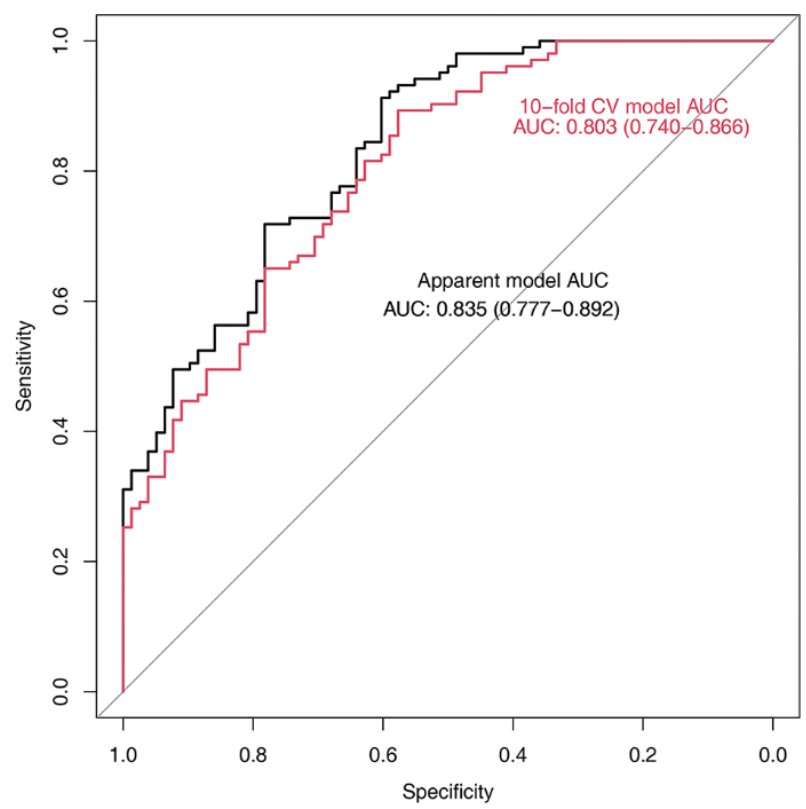
Figure 6. Adequacy of the prediction model for poor neurological outcomes in this study as determined using the Hosmer-Lemeshow test (Chi-squared = 11.4, df = 8, p = 0.178), along with the areas under the curve (AUC: 0.803, 95% confidence interval: 0.740–0.866). In this study, a 10-fold cross-validation (CV) analysis was conducted to assess the internal validity.